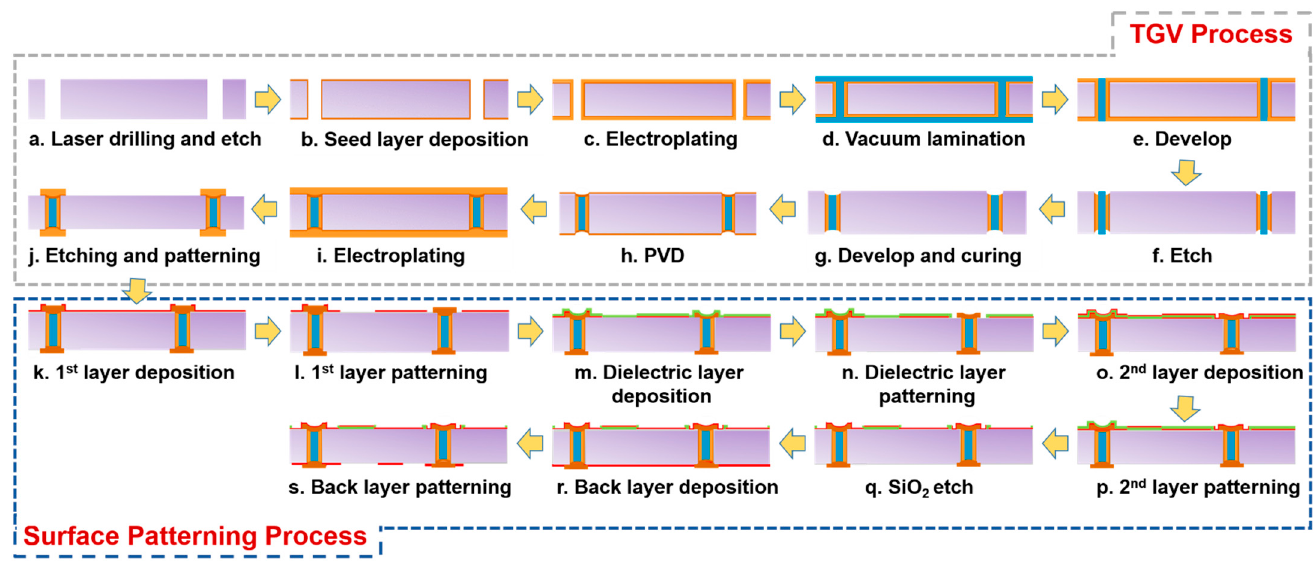
Figure 4. Process flow of charge detector fully integrated with silica glass via.